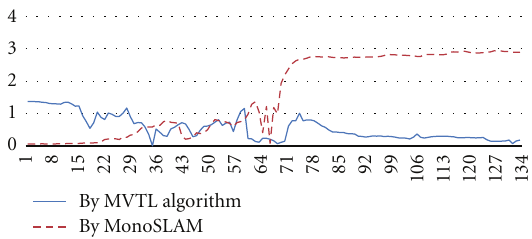
Figure 8: The comparison of the target 1 depth errors (meter) between MVTL and MonoSLAM [18] in Path B.